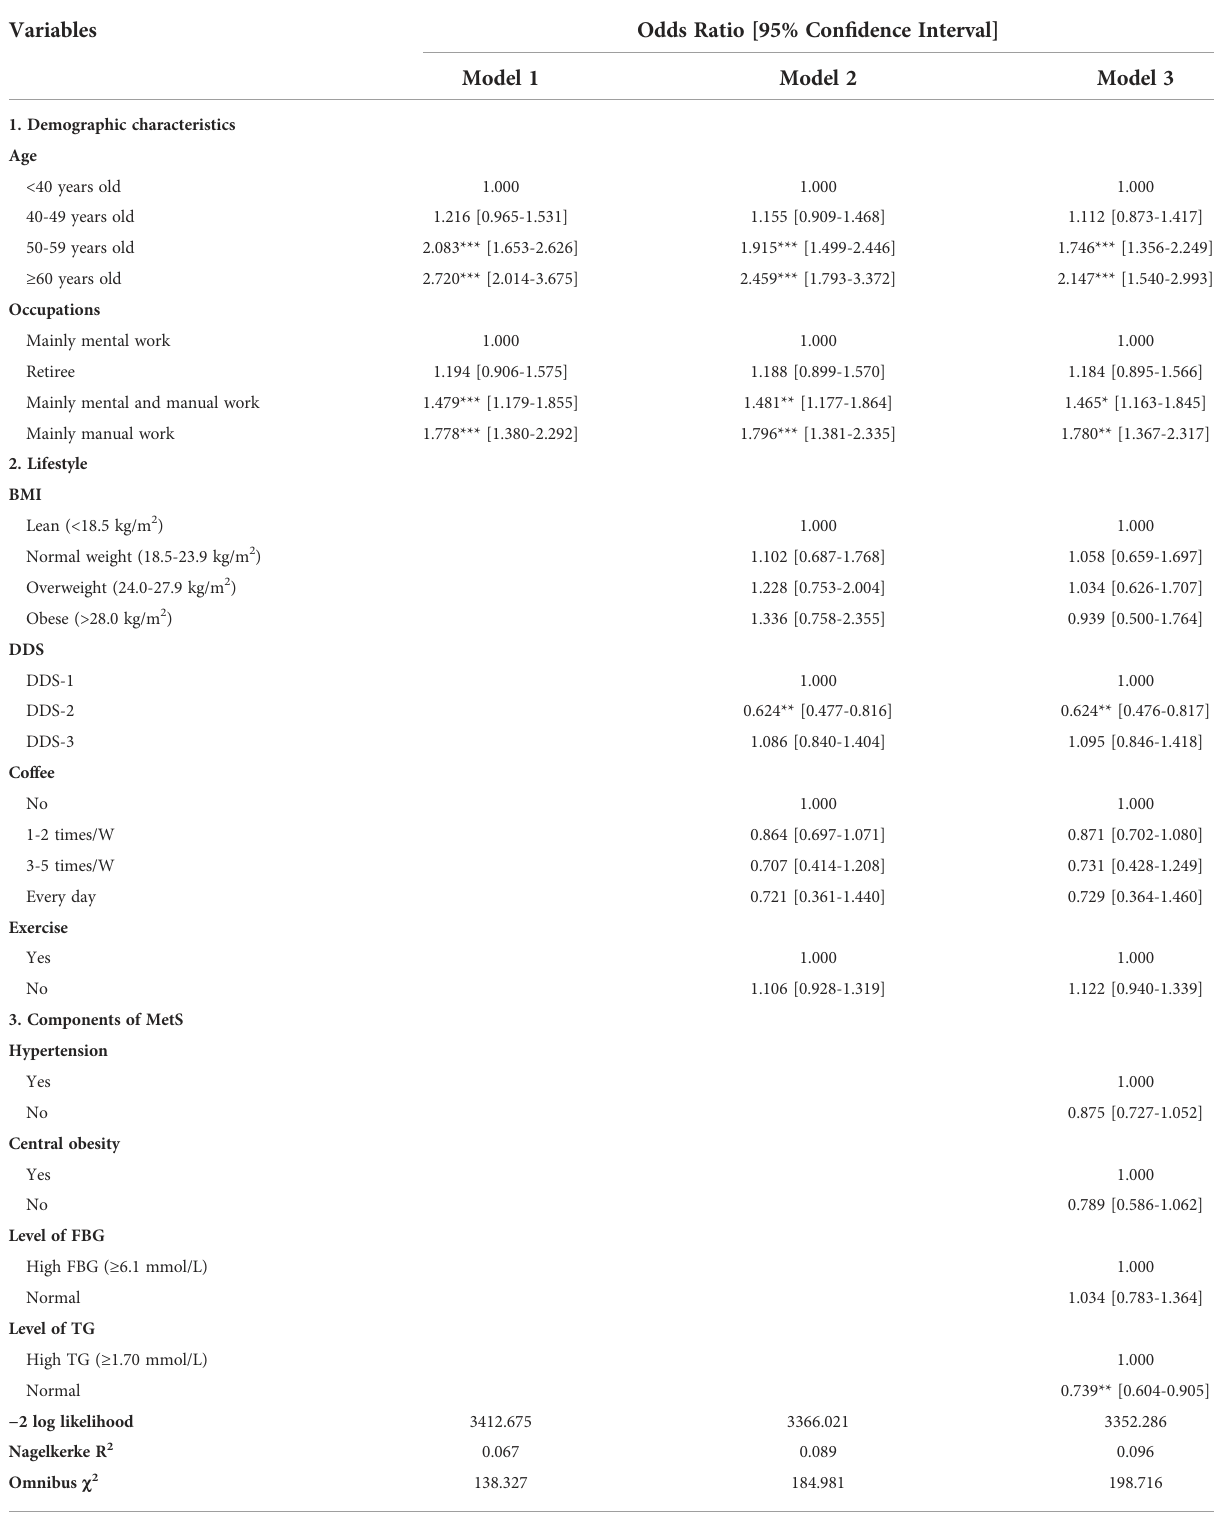
TABLE 3 Multilevel logistic regression analysis of the relationship between thyroid nodules and individual characteristics, lifestyle, and components of metabolic syndrome (N =